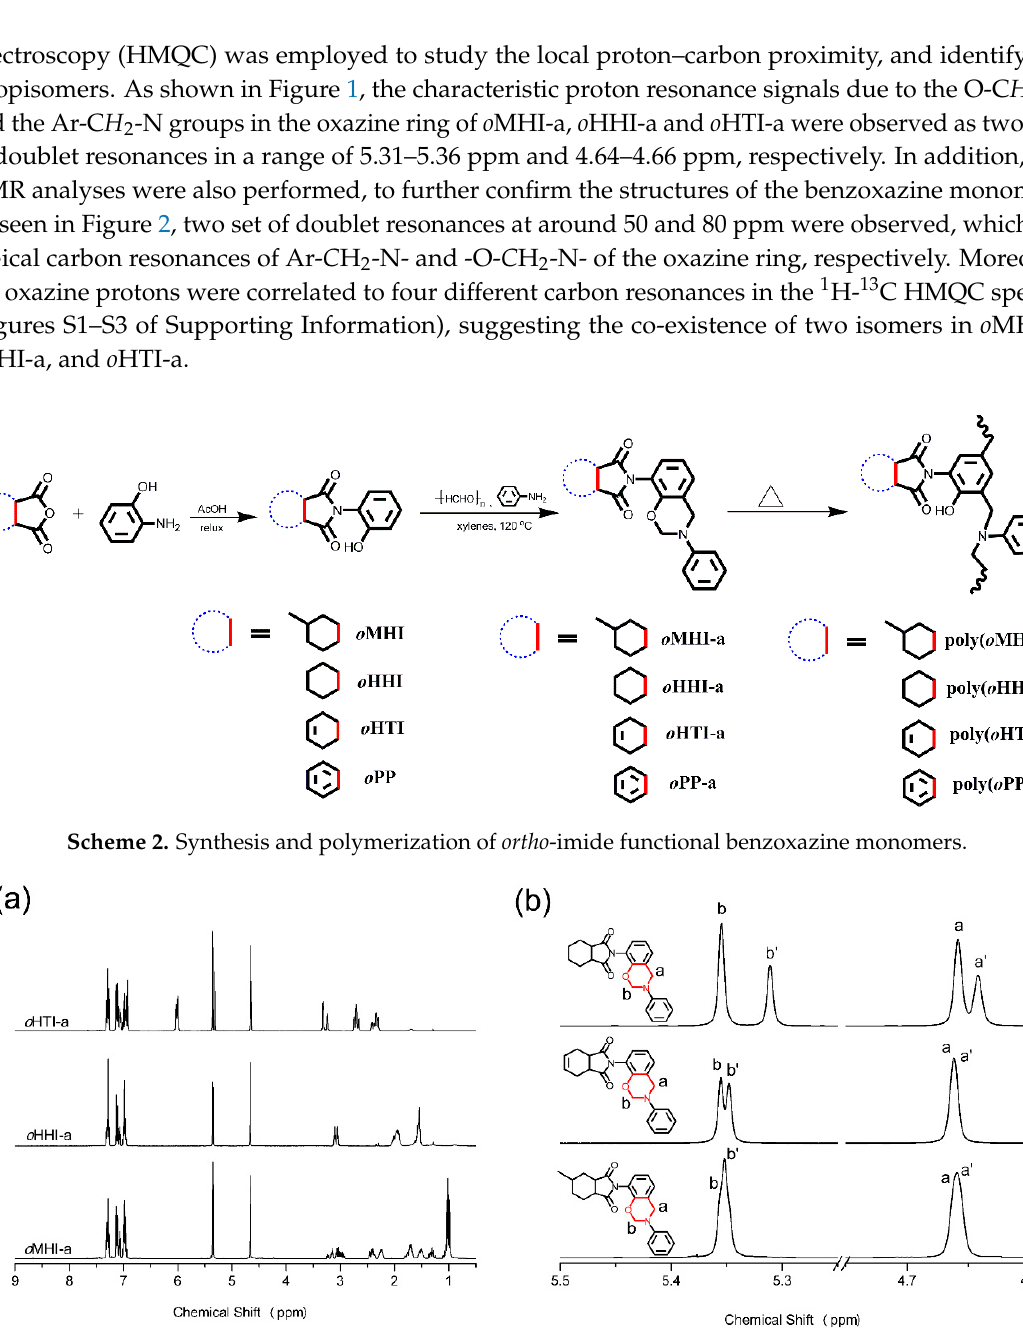
Figure 1. ( a ) 1 H NMR spectra of o MHI-a, o HHI-a and o HTI-a. ( b ) The expanded region between 4.6 and 5.5 ppm shows the two sets of doublet resonances for these monomers.